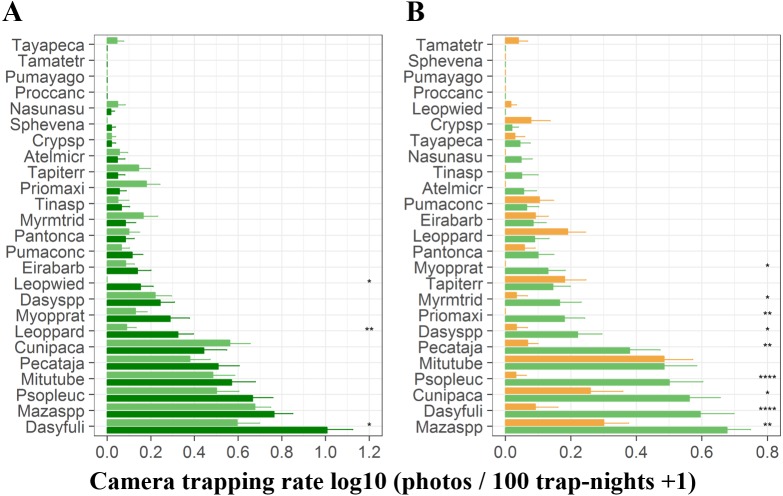
Camera trapping rate of terrestrial vertebrates recorded in terra firme and várzea forests.(A) Camera trapping rates in terra firme forests during both high- (dark green bars) and low-water phase of the flood pulse (light green bars). (B) Camera trapping rates in both terra fime and in várzea forests during the low-water phase of the flood pulse. Light green and orange bars represent terra firme and várzea forests, respectively. Species are represented by the first four letters of each genus and first four letters of each species and ordered from least to most abundant top to bottom. Asterisks indicate significant differences according to paired (A) and unpaired t-tests (B); *p ⩽ 0.05, ** p ⩽ 0.01, ***p ⩽ 0.001.